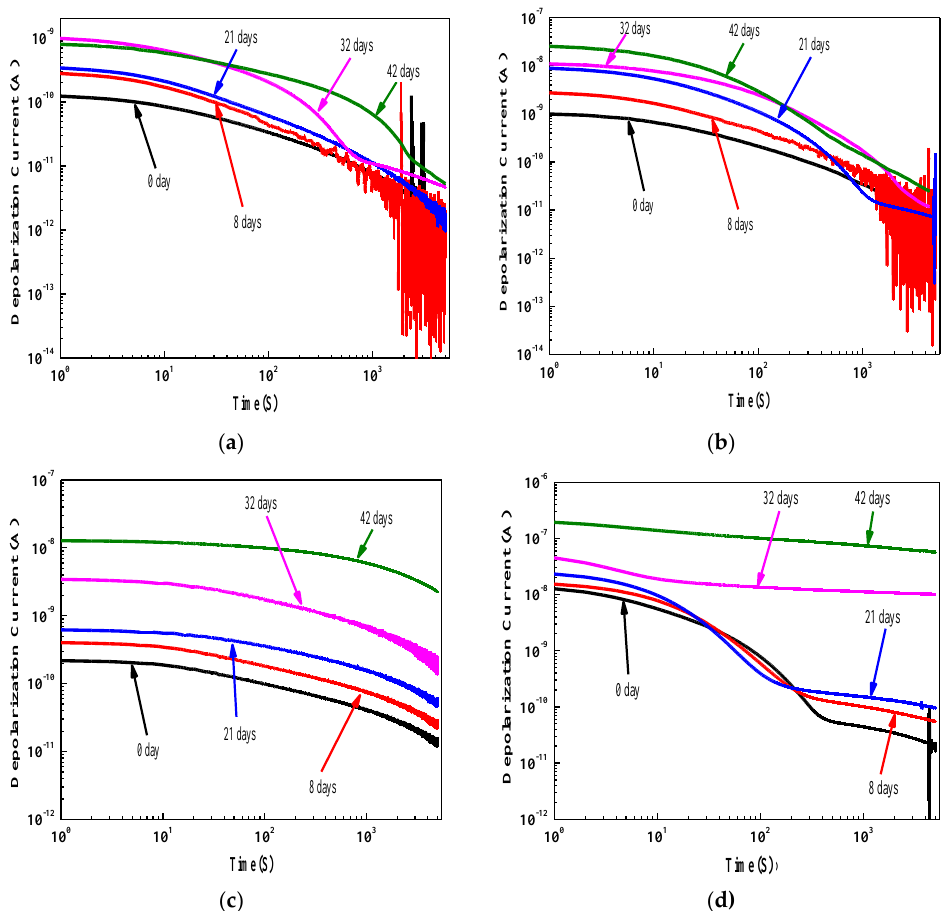
Figure 3. Depolarization current results of oil-impregnated pressboards with different ageing times. ( a ) water content 1%; ( b ) water content 2%; ( c ) water content 3%; ( d ) water content 4%.